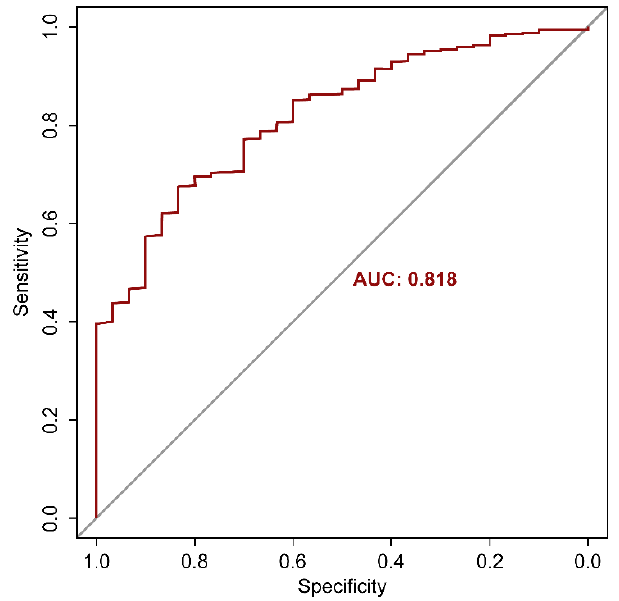
Figure 2. Area under the receiver operating characteristic curve of the suicide prediction model.